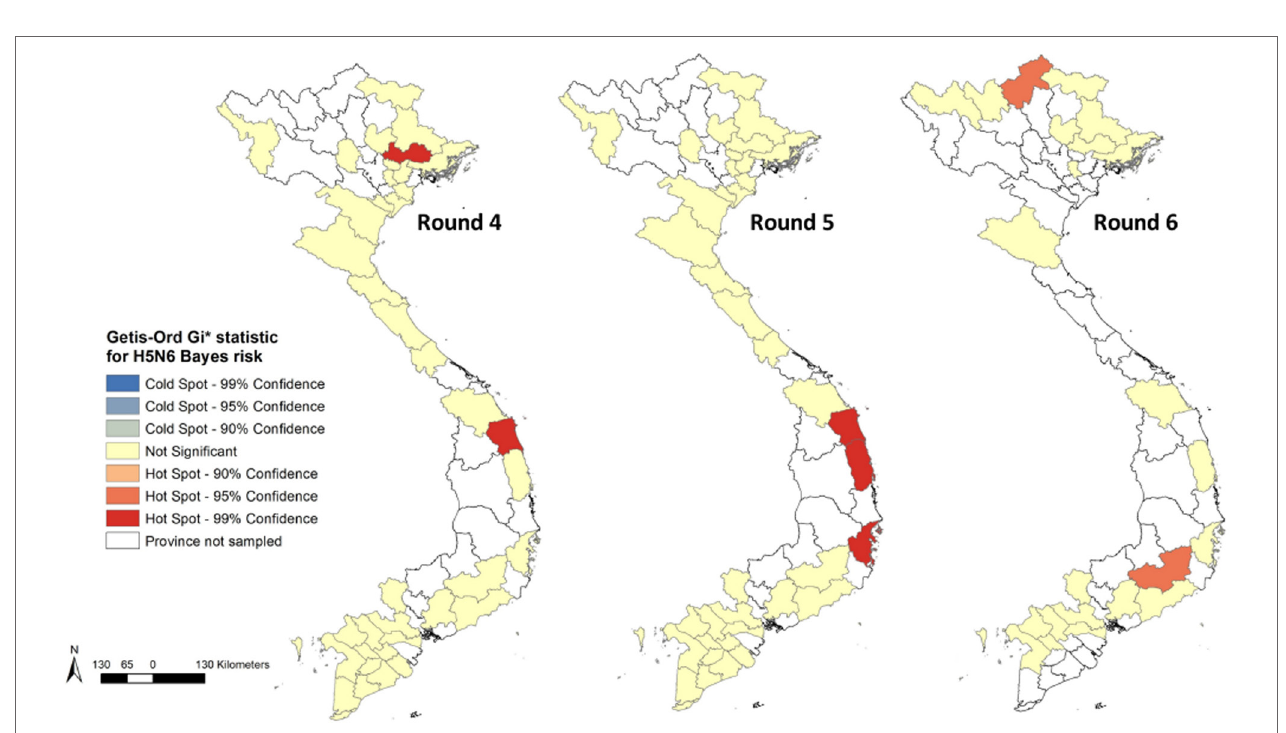
FigUre 6 | Getis-Ord GI* statistic maps showing hot-spot provinces for highly pathogenic avian influenza H5N6 empirical Bayes risk estimates for Rounds